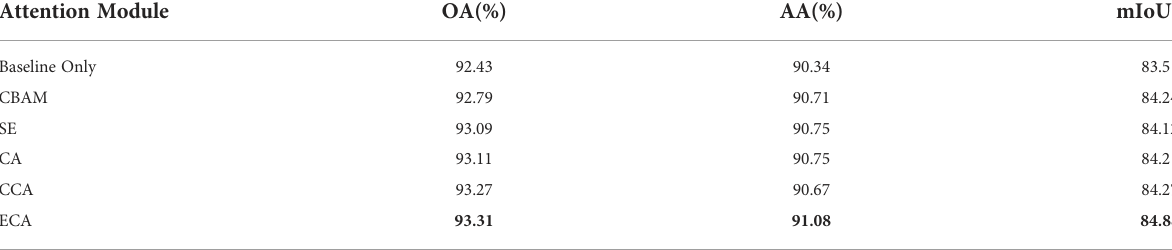
Bold font indicates the highest